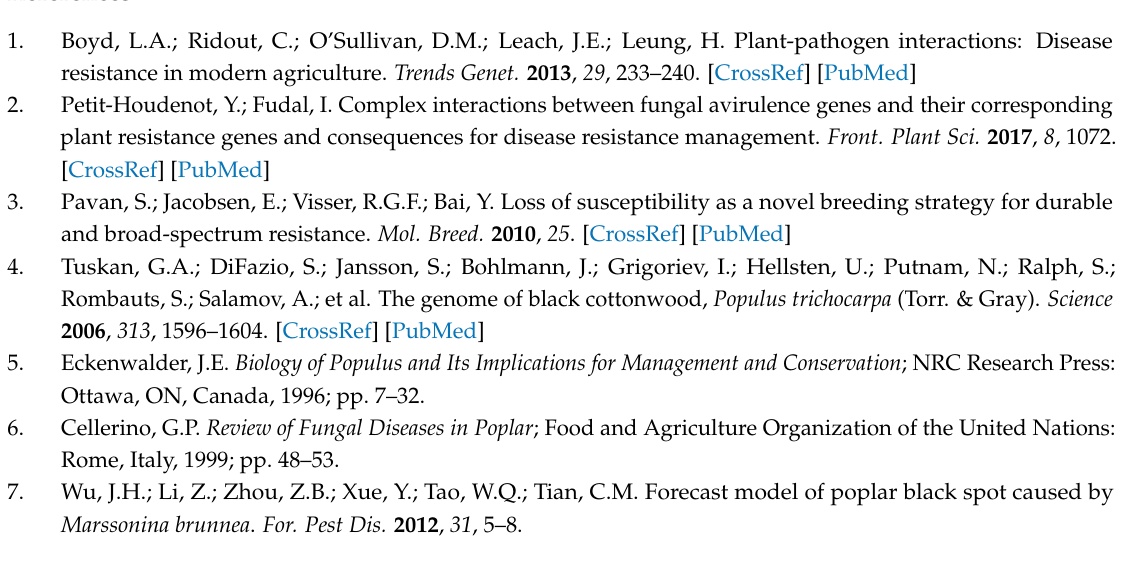
Figure S1: Validation of RNA-Seq expression patterns in two poplar sections using qRT-PCR; Figure S2: Common DEGs kept up or downregulation in three infection stages between two poplar sections; Figure S3: Common genes of each classification in Figure 5 between two poplar sections; Figure S4: KEGG map (ko04075, plant hormone signal transduction) of Leu-MO45 infection system; Figure S5: KEGG map (ko00500, starch and sucrose metabolism) of Aig-MU39 infection system; Figure S6: The gene expression pattern of some genes involved in the flavonoid biosynthesis pathway of Aig; Figure S7: The gene expression pattern of some genes involved in the ribosome biogenesis in eukaryotes pathway of Leu; Figure S8: The expression pattern of some genes involved in the flavonoid biosynthesis pathway of Leu; Figure S9: Clustering of gene expression of genes encoding RLKs in two poplar sections; Figure S10: Clustering of gene expression of genes encoding chitinases in two poplar sections; Figure S11 Analysis of several genes played important roles in plant in response to pathogens, Table S1: RT-PCR primers used in this study; Table S2: Details of GO terms enriched by up and downregulated DEGs of Aig at 6, 36 and 96 hpi of three infection stages in Figure 4; Table S3: Details of GO terms enriched by up and down regulated DEGs of Leu at 6, 36 and 96 hpi of three infection stages in Figure 4; Table S4: Details of Mapman analysis for Aig in Figure 5a; Table S5: Details of Mapman analysis for Leu in Figure 5b; Table S6: GO enrichment analysis of genes selected according to co-expression analysis (Figure 6); Table S7: KEGG enrichment analysis of genes selected according to co-expression analysis (Figure